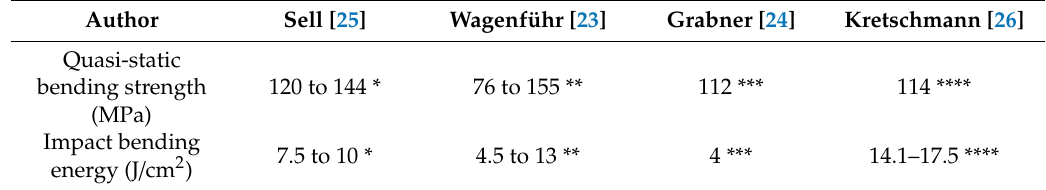
Table 3. Average ranges of quasi-static and impact bending energy values for small clear wood specimens of birch.